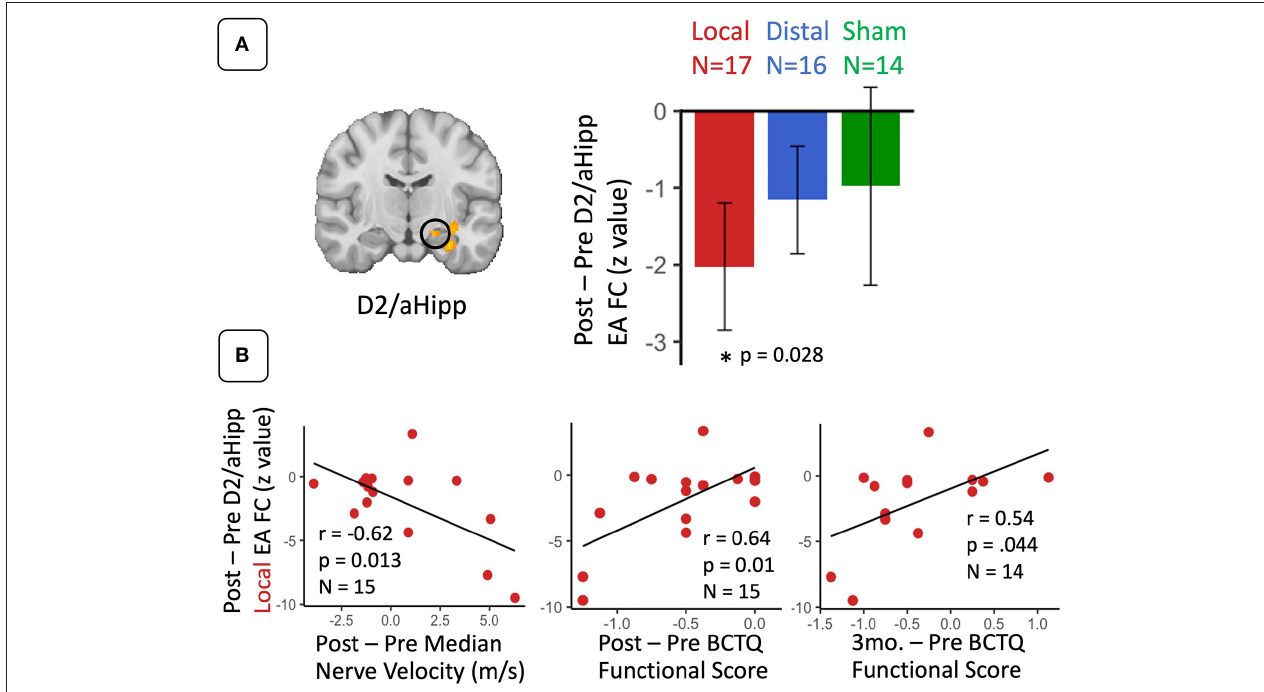
FIGURE 3 | For CTS patients, S1 (D2) functional connectivity to anterior hippocampus during sustained electroacupuncture (EA) were reduced following local EA therapy and linked with clinical variables following local treatment. (A) D2 to anterior hippocampus functional connectivity during EA decreased following local treatment only. (B) These decreases in D2 to anterior hippocampus connectivity in the local group were correlated with post-therapy changes in median nerve conduction velocity and symptom severity, and 3-month changes in symptom severity. N.B. S1, primary somatosensory cortex; D2, S1 cortical representation of the second digit of the hand; aHipp, anterior hippocampus; FC, functional connectivity. ROIs for this longitudinal analysis were defined from regions showing differences between CTS patients and healthy controls D2 functional connectivity during electro-acupuncture at